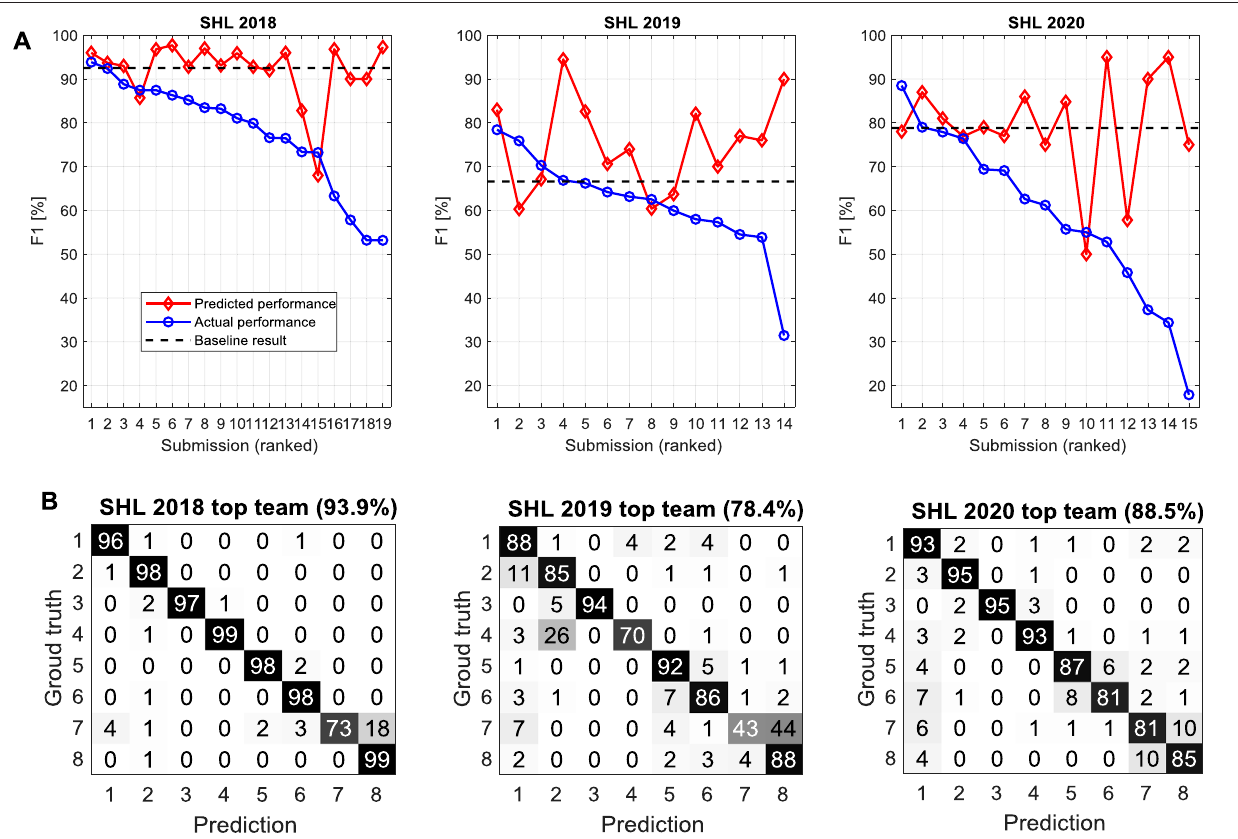
FIGURE 9 | Submission results of SHL 2018 – 2020. (A) Submission ranked based the F1 score for the testing data. The baseline results from the organization committee ( Section 5 ) are also indicated. (B) Confusion matrix from the top team. The eight class activities are: 1 — Still; 2 — Walk; 3 — Run; 4 — Bike; 5 — Car; 6 — Bus; 7 — Train; 8 —